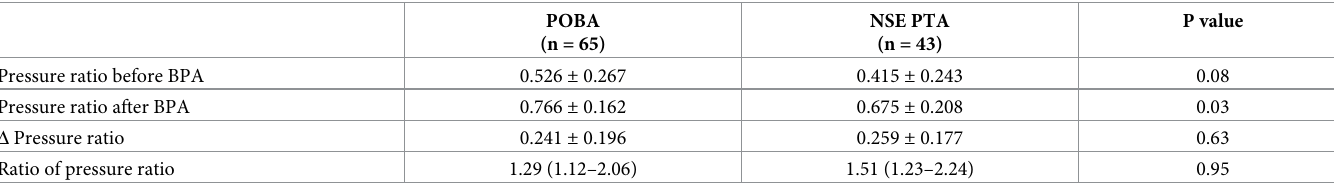
Table 3. Pressure ratio of target lesion before and after BPA.